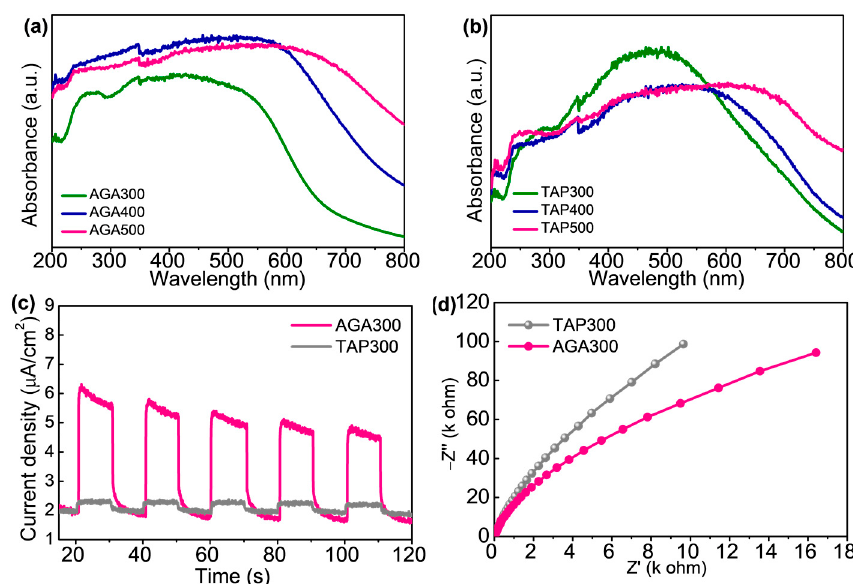
Figure 2. Ultraviolet-visible spectroscopy (UV-vis) absorbance spectra of ( a ) AGA- and ( b ) TAP- derived materials. ( c ) Transient photocurrent responses and ( d ) Nyquist electrochemical impedance spectroscopy (EIS) plots of AGA300 and TAP300.